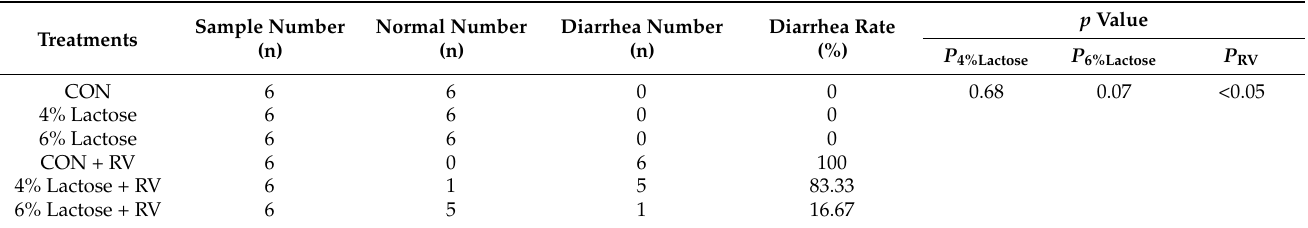
Table 5. Effect of dietary lactose supplementation and/or RV challenge on diarrhea status in weaned pigs 1 .